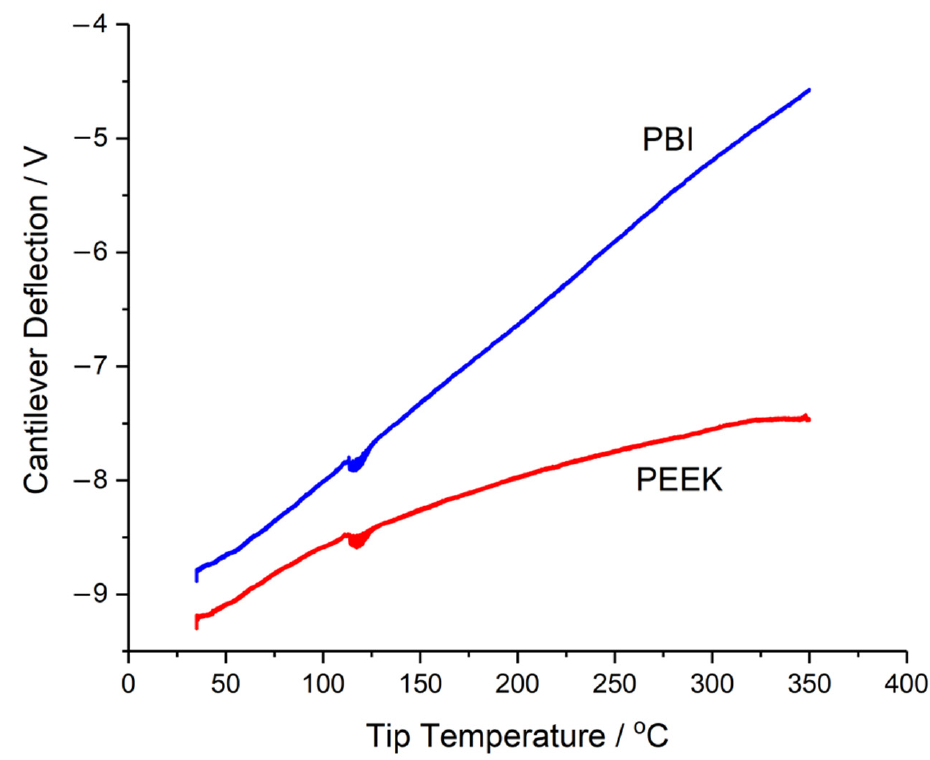
Figure A5. NanoTA profiles of 10 mm thick PBI and PEEK polymer samples.